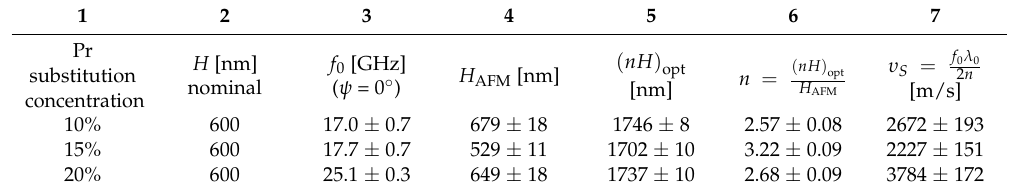
Table 2. Evaluation of the parameters of (Bi 1 − x Pr x )(Fe 0.95 Mn 0.05 )O 3 films deposited on Si by combining